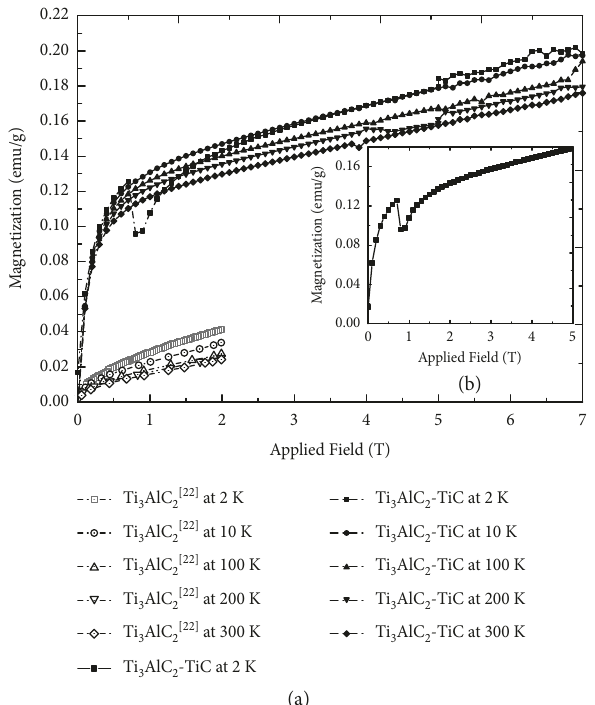
Figure 8: Magnetization versus applied magnetic field for Ti TiC composites at 2–300 K (a); local enlargement of magnetization curve at 2K (b).